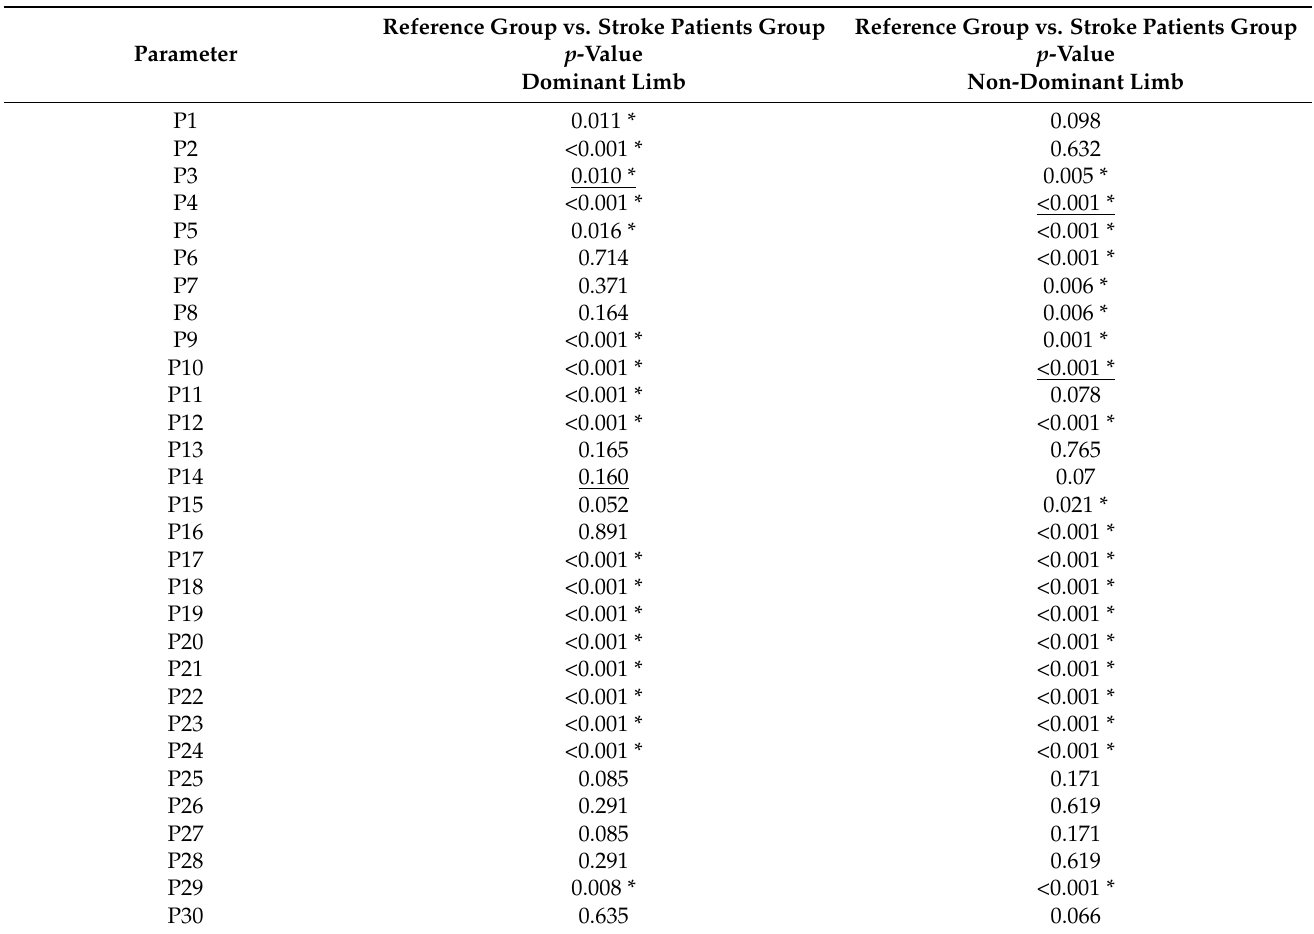
Table 3. Differences between the selected input parameters in the reference group and the stroke patient